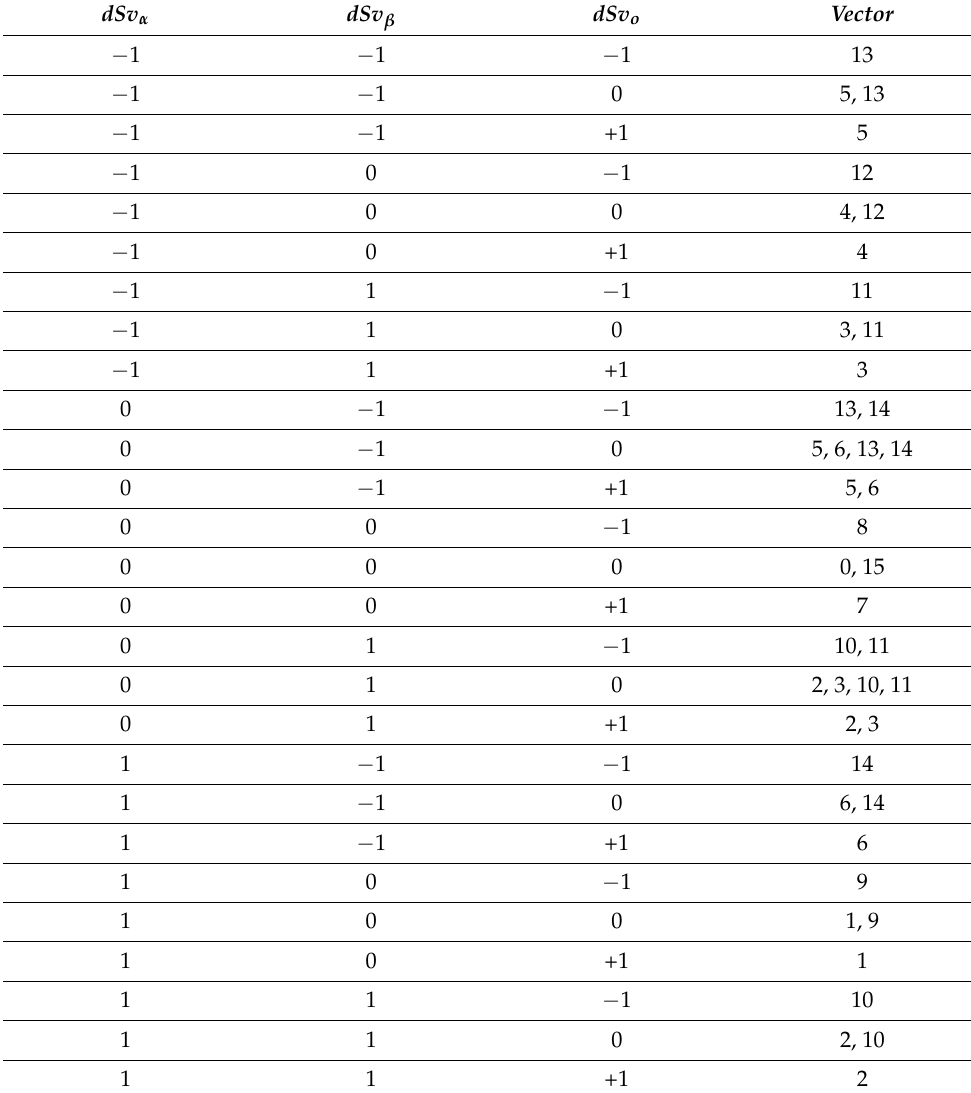
Table 2. Adopted Voltage Vectors Function of the Sliding Surfaces for Four-Leg